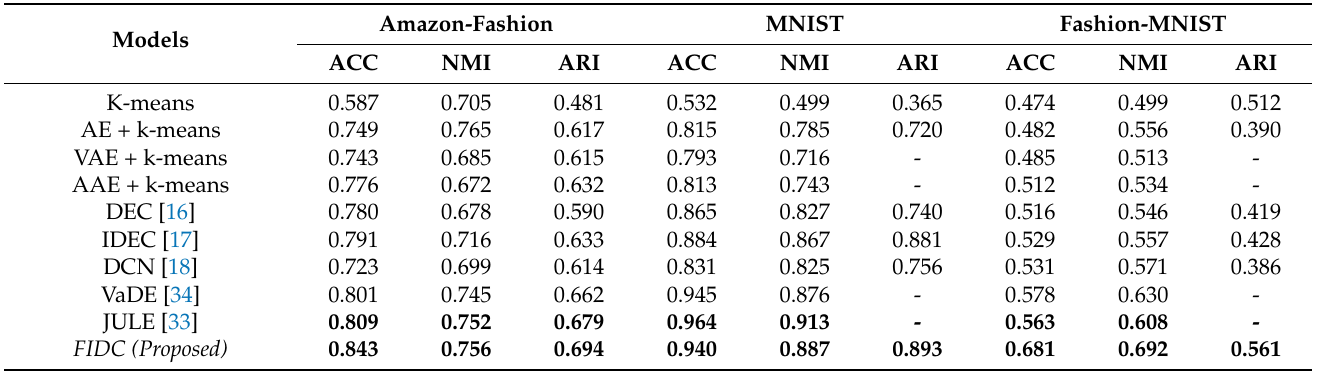
Table 4. Clustering performance of various methods on open-source datasets expressed in terms of accuracy (ACC), normalized mutual information (NMI), and adjusted Rand index (ARI). All baseline method results were obtained from the corresponding code or original papers. The result is not available, indicated by the mark “-”.